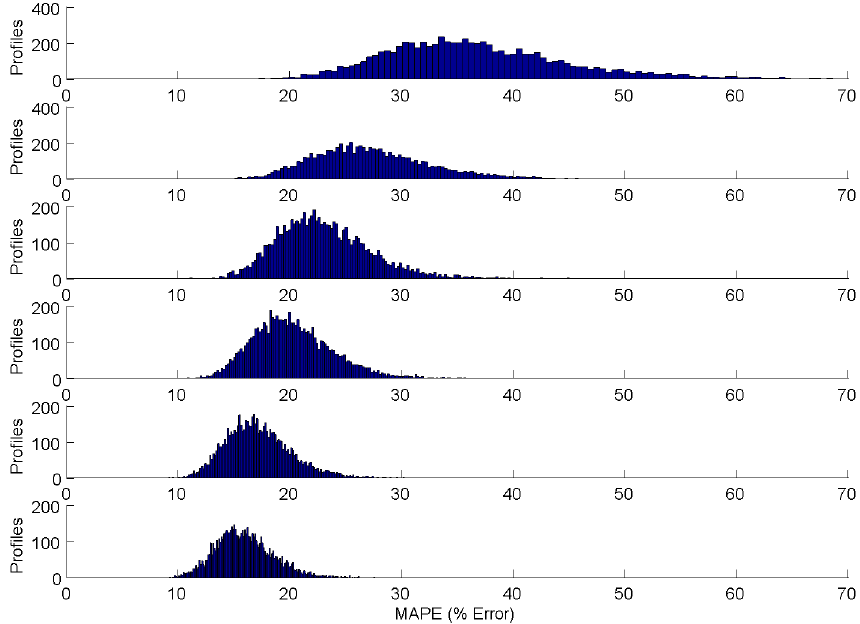
Figure 1. Five histograms showing the error distributions between the forecasted and actual demand in demand aggregation sizes of five, 10, 15, 25 and 35 individual demand profiles, respectively (from top to bottom). The forecasting methodology used to produce these errors can be found in the appendix of